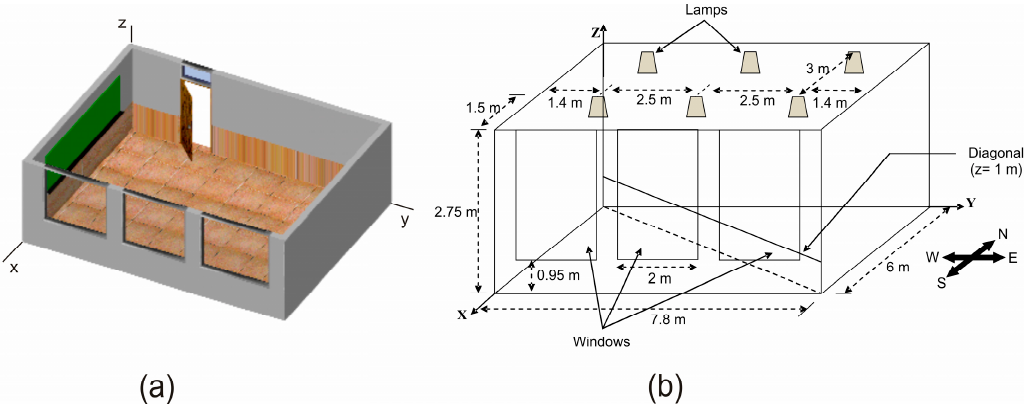
Figure 4. Graphical representation of the room: ( a ) 3D design; ( b ) Display of dimensions.